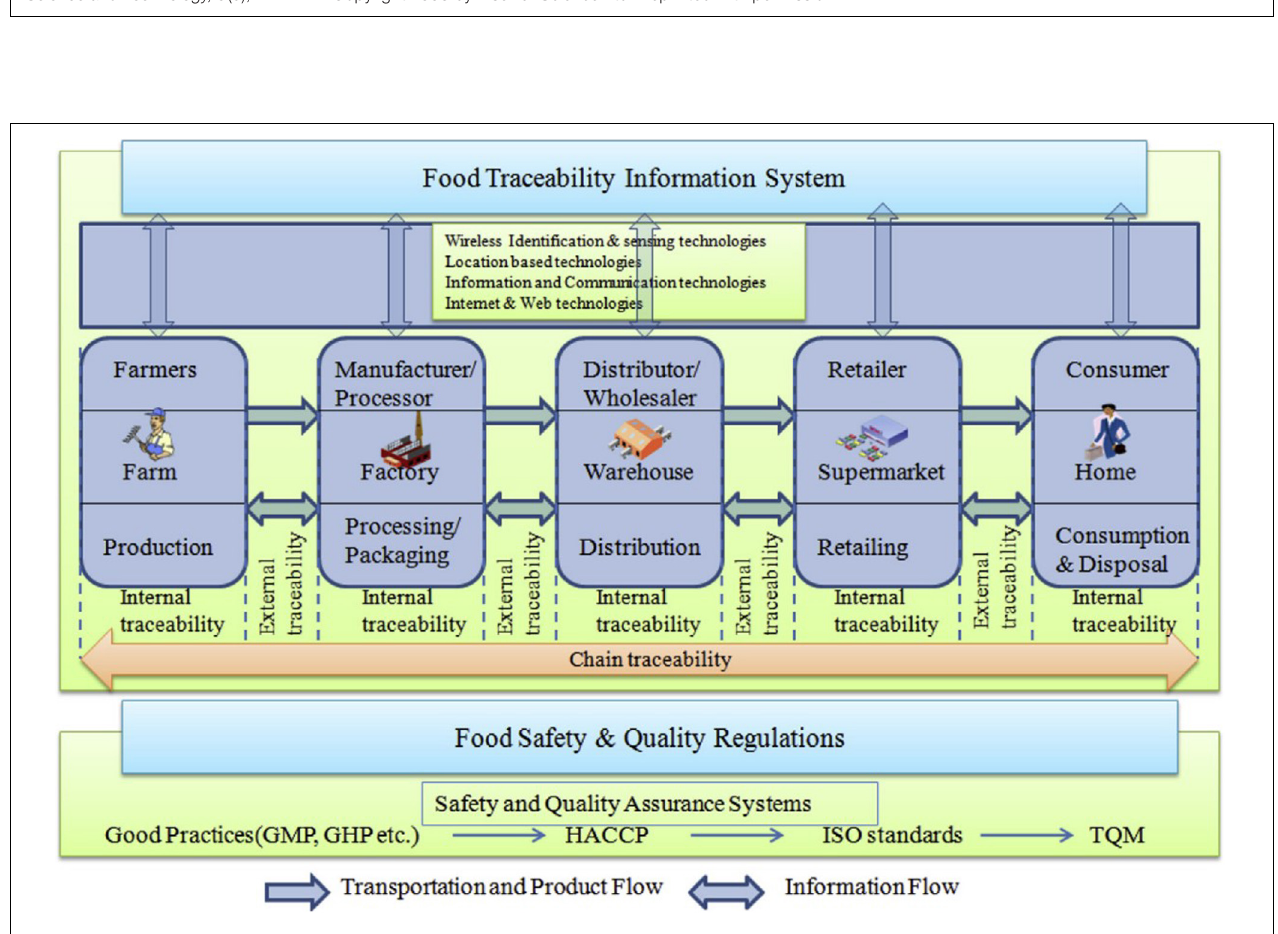
FIGURE 2 | General framework of a food traceability system. Reprinted from “Traceability in a Food Supply Chain: Safety and Quality Perspectives,” by Aung and Chang, 2014, Food Control , 39 (1), 172–184. Copyright 2014 by Elsevier Science Ltd. Reprinted with permission.